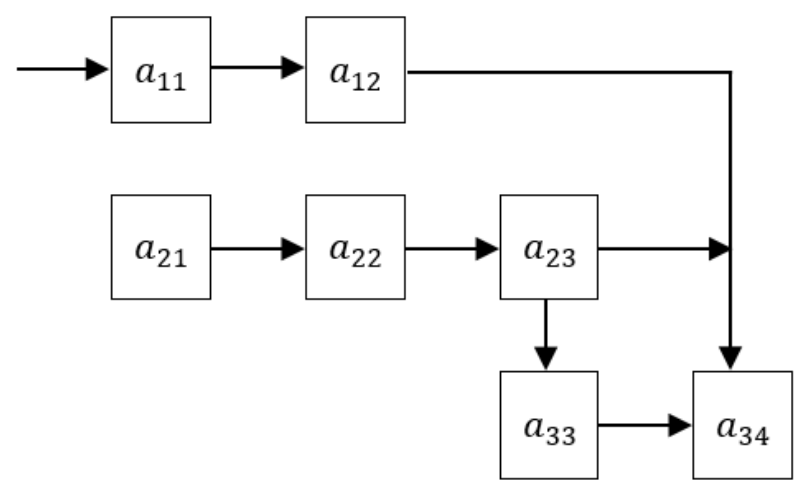
Figure 7. Assembly line with seven workstations.